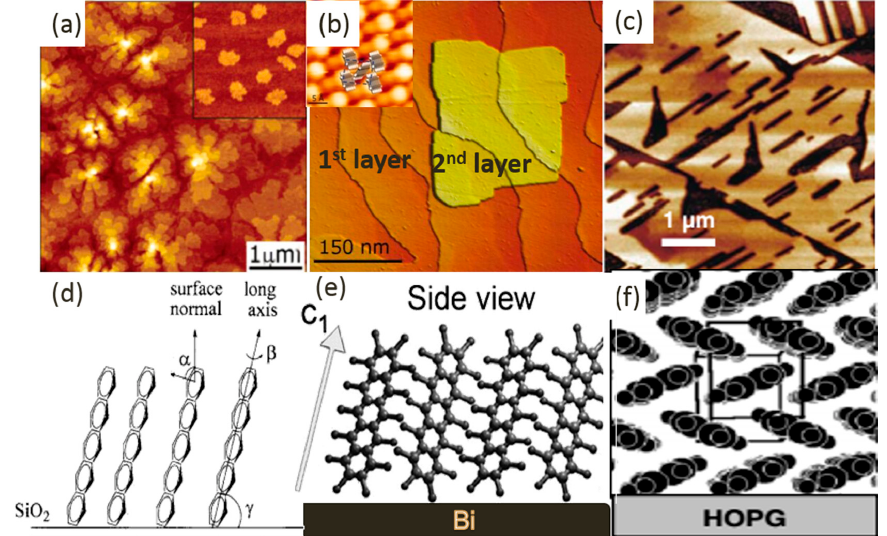
Figure 2. Morphologies of pentacene thin films on different substrates. ( a ) AFM topography image of fractal islands of pentacene on SiO 2 at a coverage of ~3 ML. Inset: nucleation at submonolayer coverage. ( b